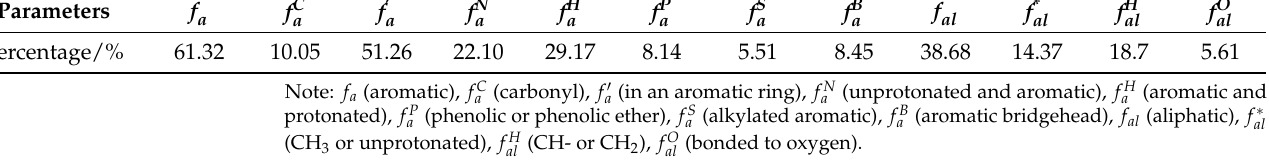
Table 3: X BP = f B